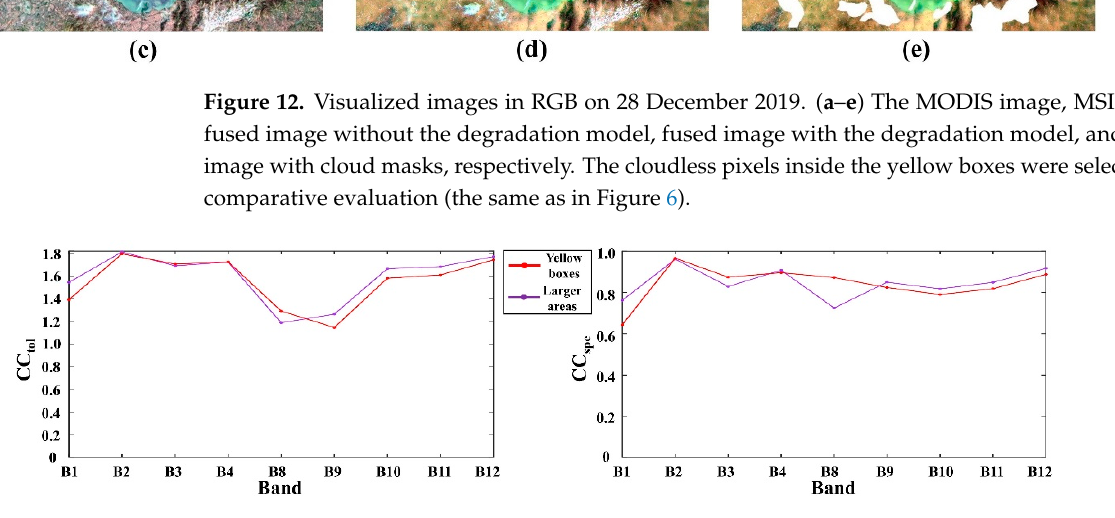
Figure 13. Comparison of evaluation metrics for yellow boxes (red line) and larger areas (purple line, all pixels outside of the masks) on 28 December 2019.